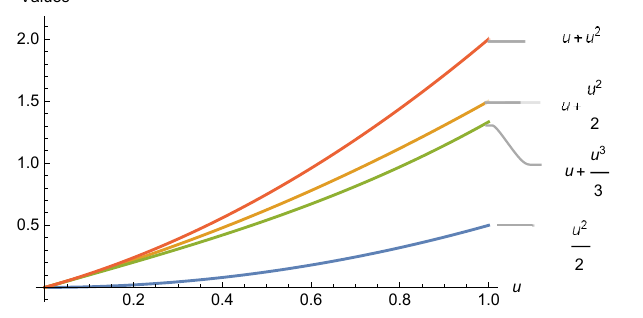
Figure 1. Graphical validation of Theorem 1.